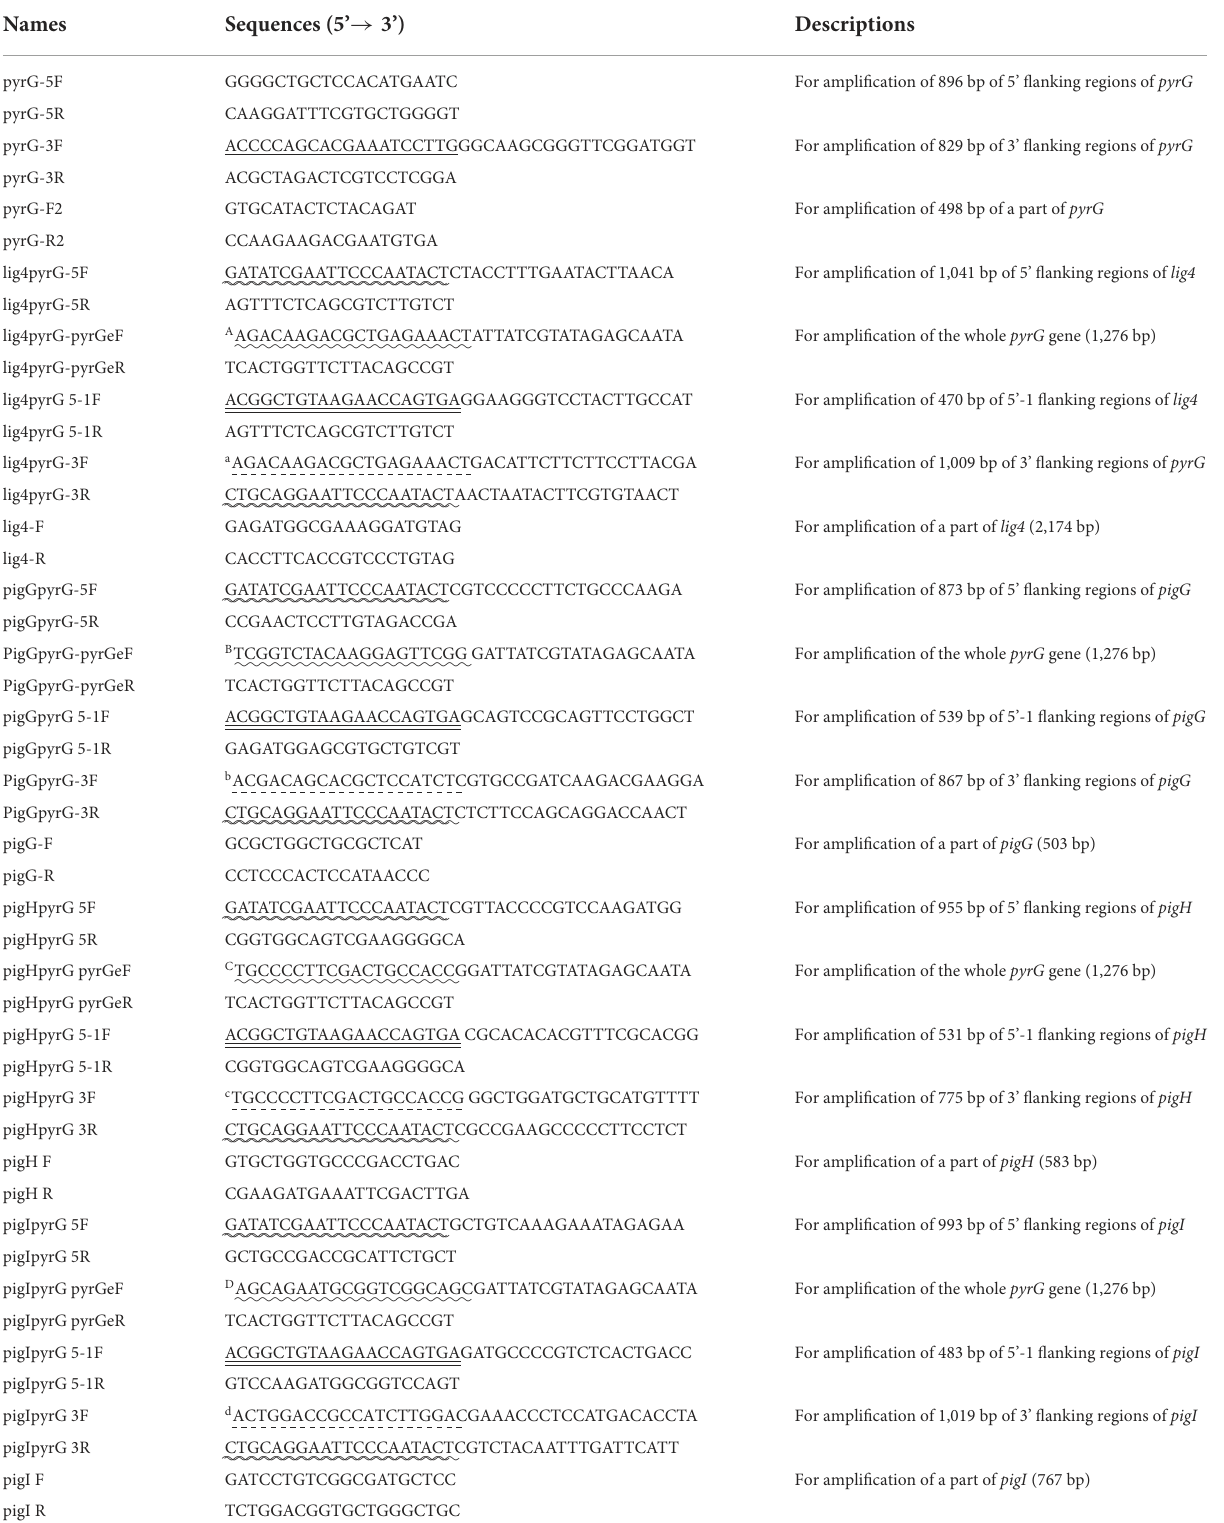
TABLE 2 Primers used in this study.